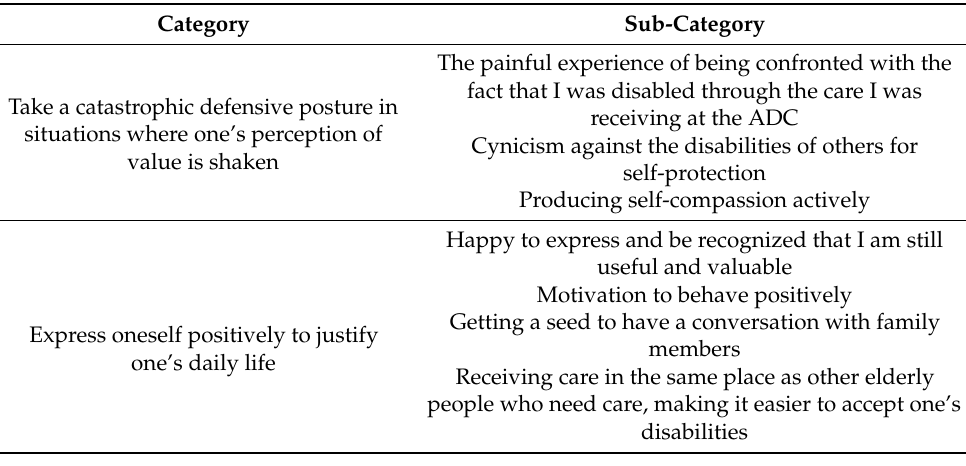
Table 2. Summary of categories of clients’ experiences with